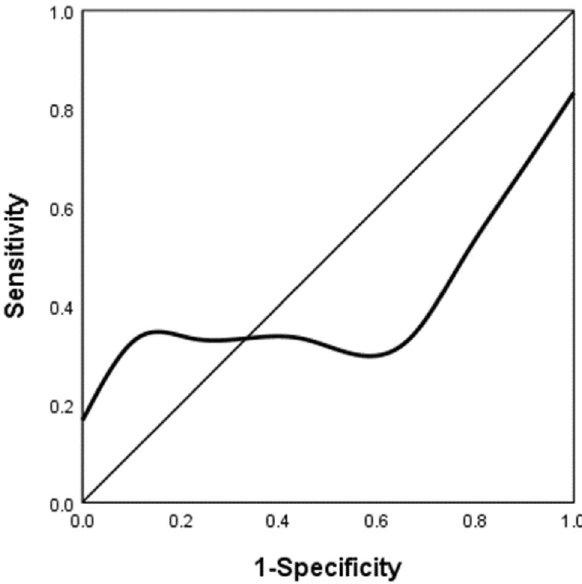
Figure 2. Receiving operating characteristic (ROC) curve showing the trade-off between sensitivity and specificity by considering from interval between SEMS placement and surgery to the occurrence of postoperative complications (n =